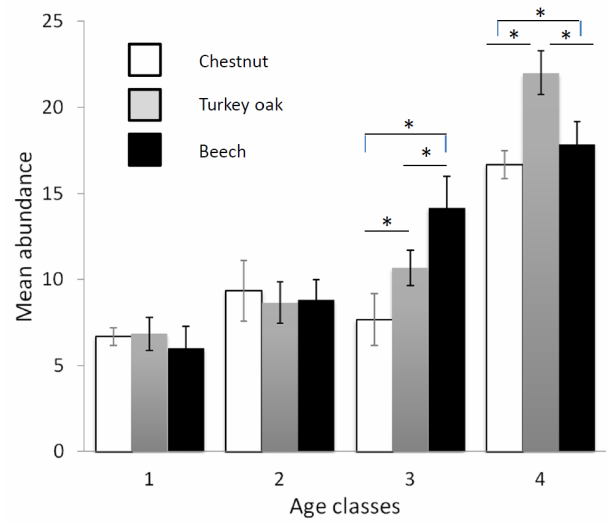
Figure 2. Mean abundance of forest bird species (see Table 2) in the different forest habitats (age class and tree composition). Chestnut in white, Turkey oak in grey and beech in black. Error bars represent the standard deviation.